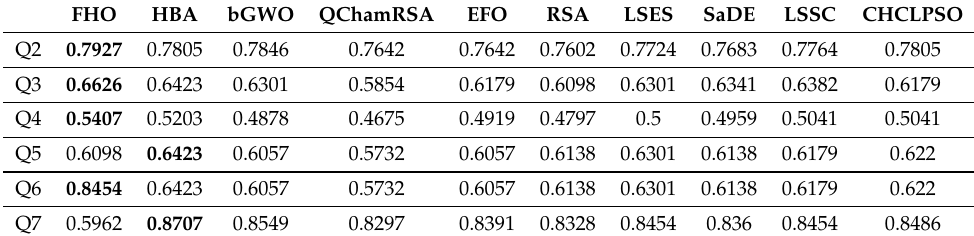
Table 10. Recall results for the multi-class